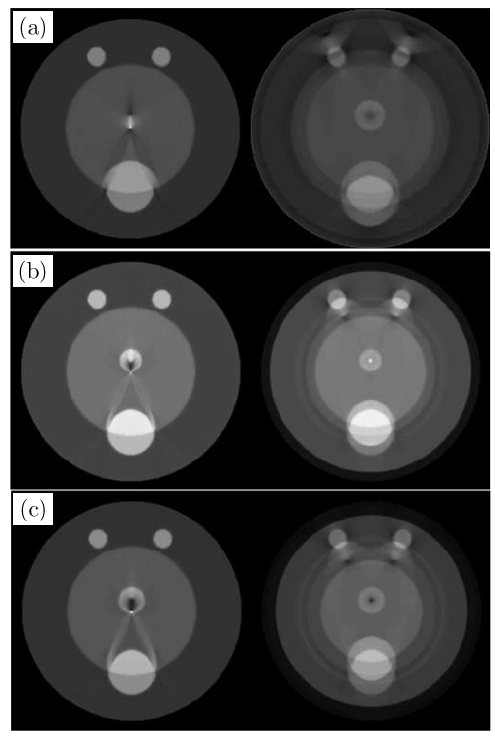
Fig. 4. Images reconstructed from simulated thermoacoustic tomography measurement data containing the e®ects of acoustic heterogeneities. The images in sub¯gures (a), (b), and (c) were reconstructed from data corresponding to acoustic speed map with v 1 / v 0 ¼ 0 : 9, 1.07, and 1.12, respectively. The images in the left and right panels of each sub¯gure were reconstructed from half- and full-time datasets, respectively. Reproduced with permission from Ref.